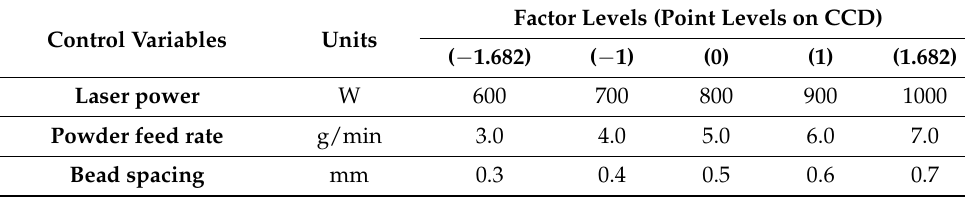
Table 3. Control variables for experimental cases of CCD and their